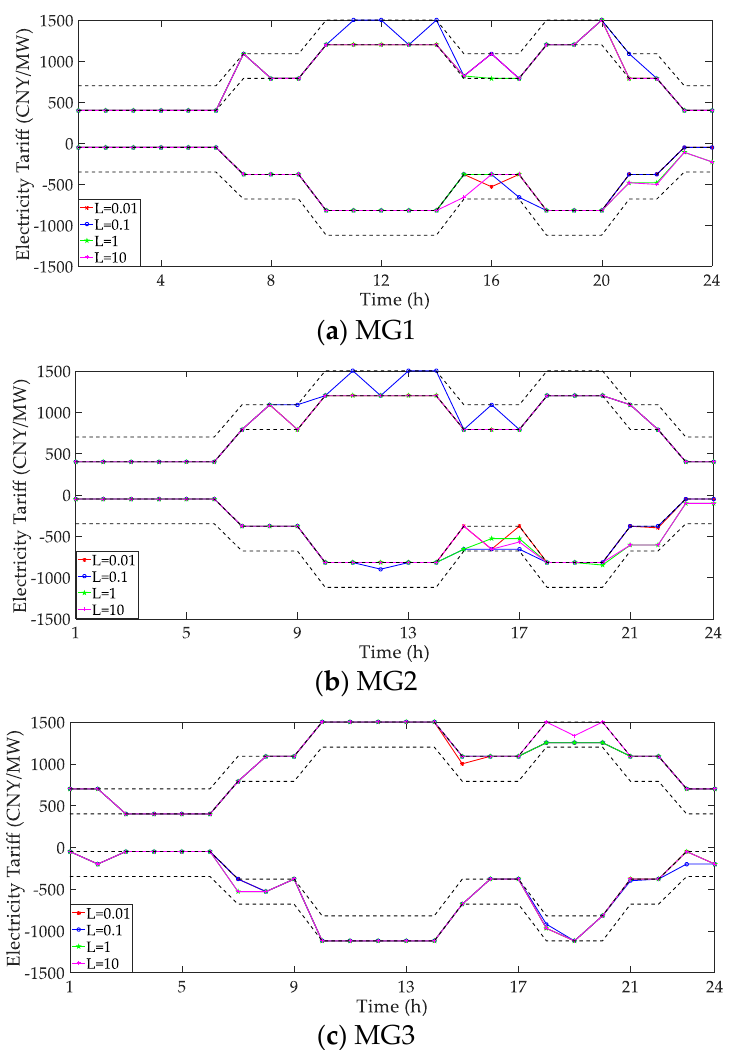
Figure 4. Electricity tariff between MA and MGs when P2P energy sharing is not allowed.